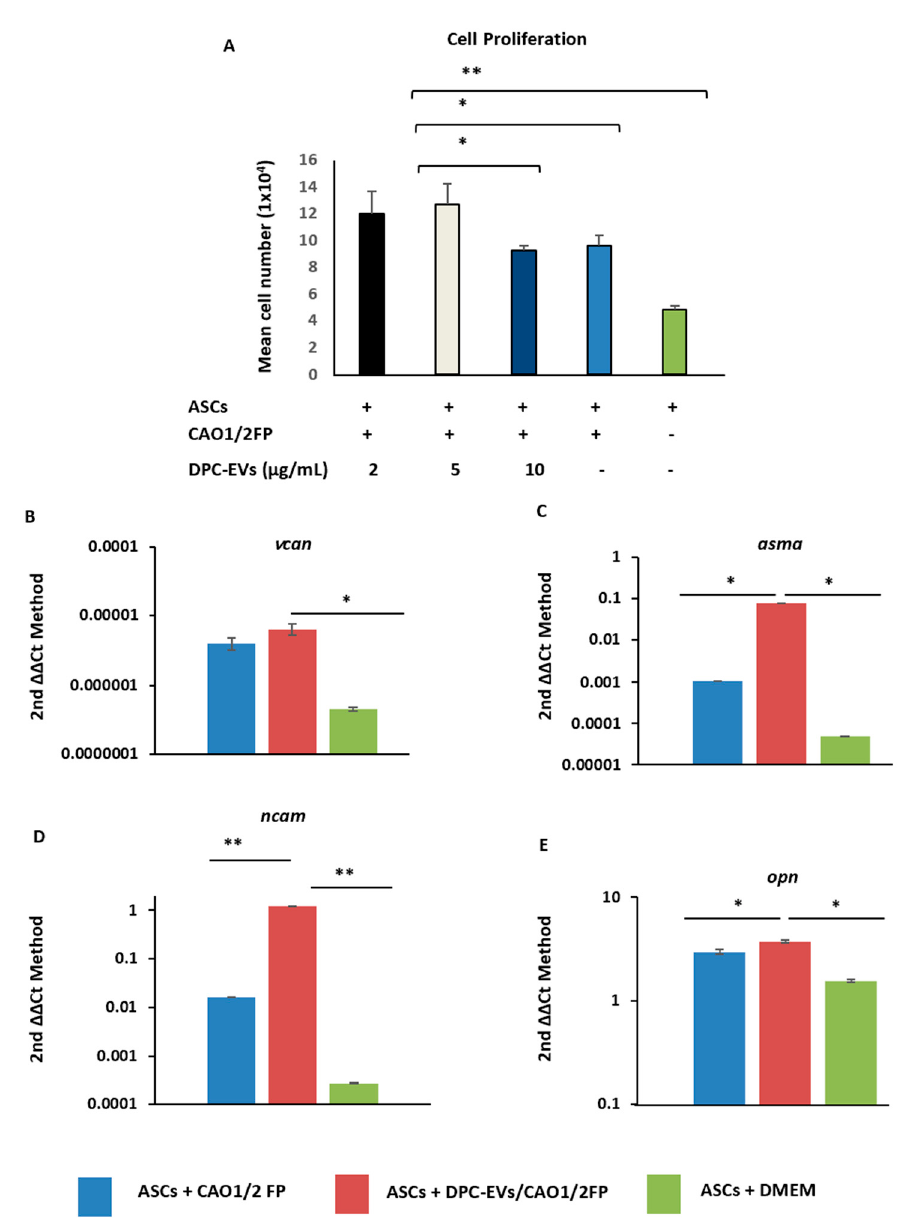
Figure 2. Proliferation and hair-related gene expression of adipose-derived stem cells (ASCs) incubated with dermal papilla cell-derived extracellular vesicles (DPC-EVs) in combination with CAO1/2FP. ( A ) Effect of DPC-EVs on ASC proliferation. ( B – E ) Expression of the DPC-related genes in the ASC spheroids. Spheroids were prepared in CAO1/2FP medium ± DPC-EVs or DMEM-FBS. The DPC-related genes, vcan ( B ), asma ( C ), ncam ( D ), and opn ( E ), were analyzed with Taqman-based quantitative PCR. The average gene expression for each category was obtained from two independent experiments measured in triplicate, and data are presented as the mean value ± SD (Error bars). * p < 0.05, and ** p < 0.01.